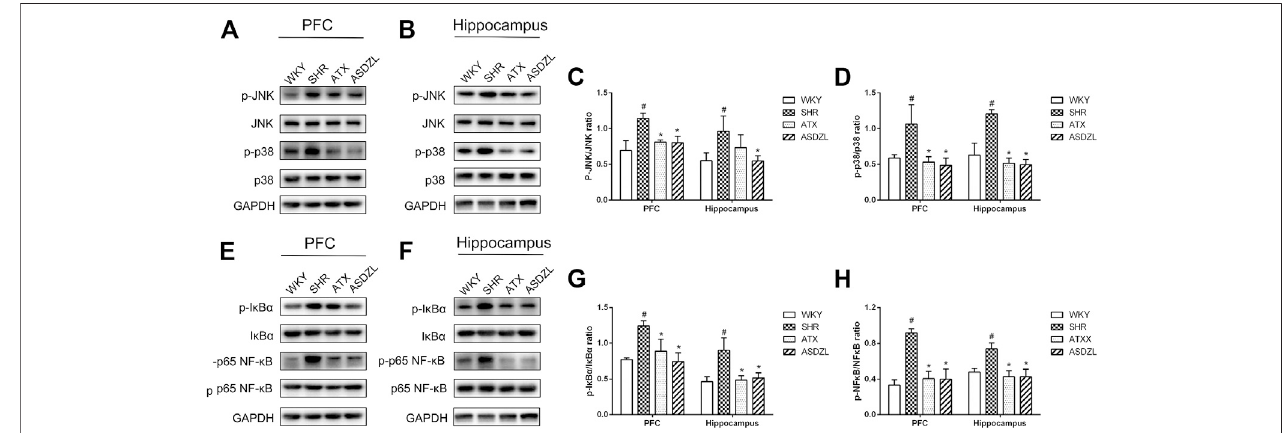
FIGURE 6 | Effect of ASDZL on MAPK and NF- κ B signaling pathways. (A) Western blot analysis of p -JNK, JNK, p-p38 and p38 levels in PFC; (B) Western blot analysisof p -JNK,JNK,p-p38andp38levelsinhippocampus; (C) , (D) Relativelevelsof p -JNKandp-p38inPFCandhippocampus; (E) Westernblotanalysisof p -I κ B α